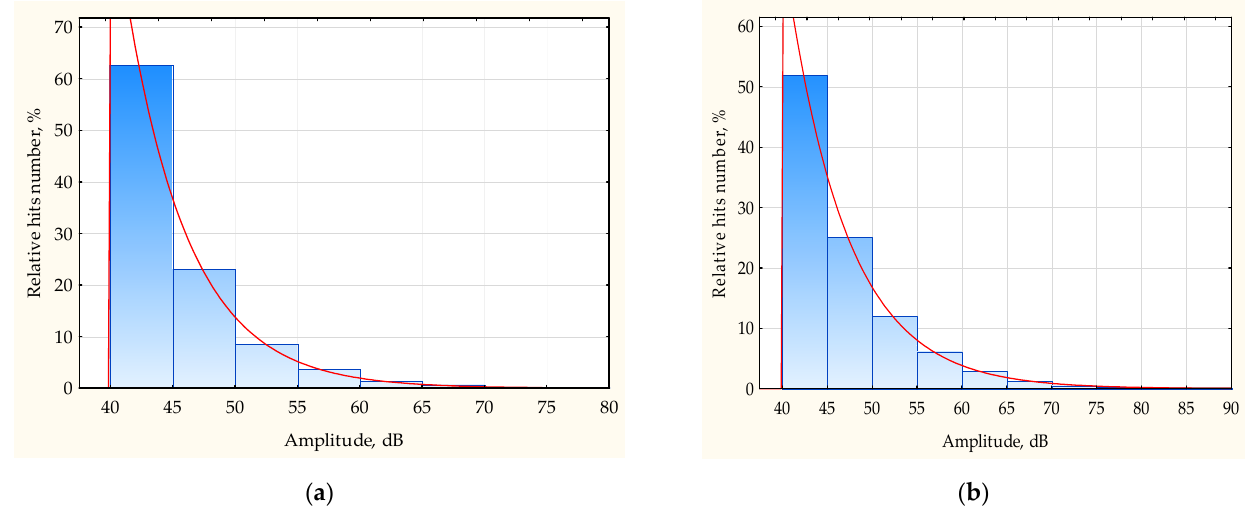
Figure 9. Distribution of AE hits amplitudes for defect-free dissimilar weld specimen ( a ), and for a specimen with a confirmed presence of diffusion interlayers ( b ).